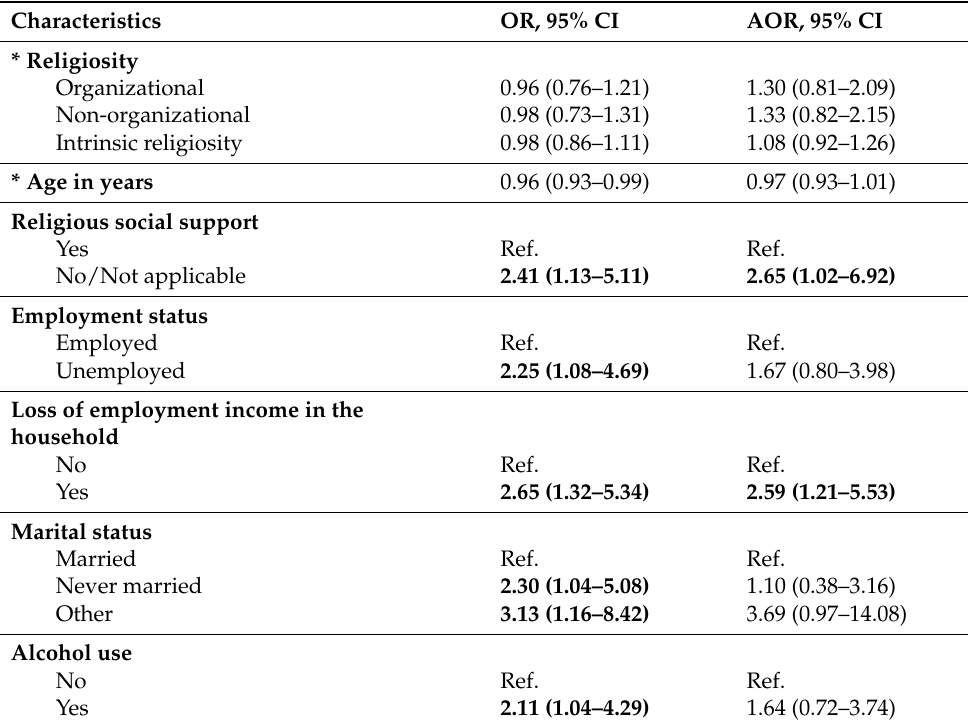
Table 3. Unadjusted and Adjusted Odds Ratios of the Predictors of Incident Mental Health Disorders, African Immigrant COVID-19 Study